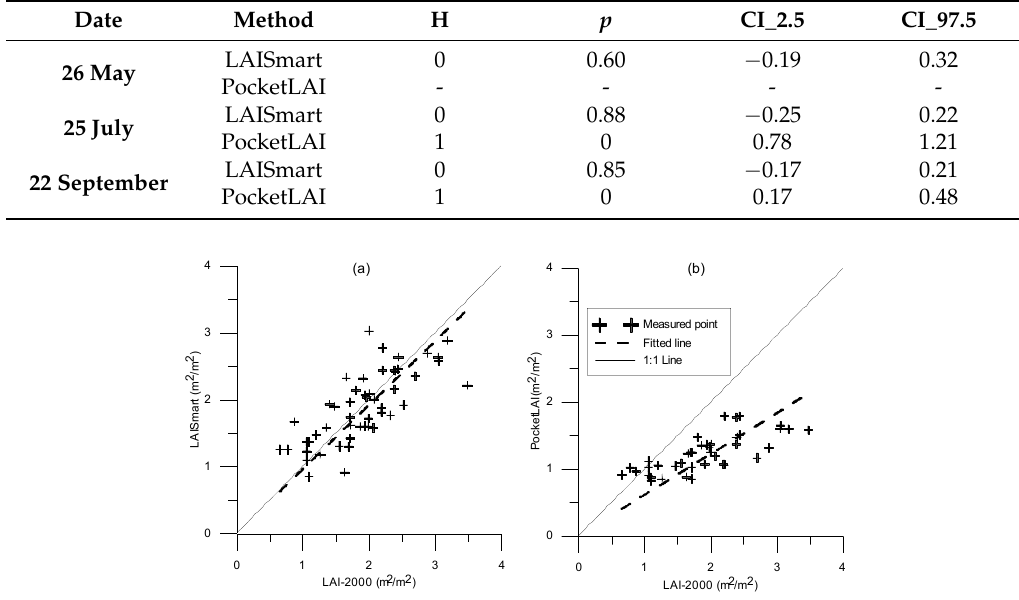
Table 4. Results of Student’s t -test results for the LAIs of smartphone sensors and those of LAI-2000.